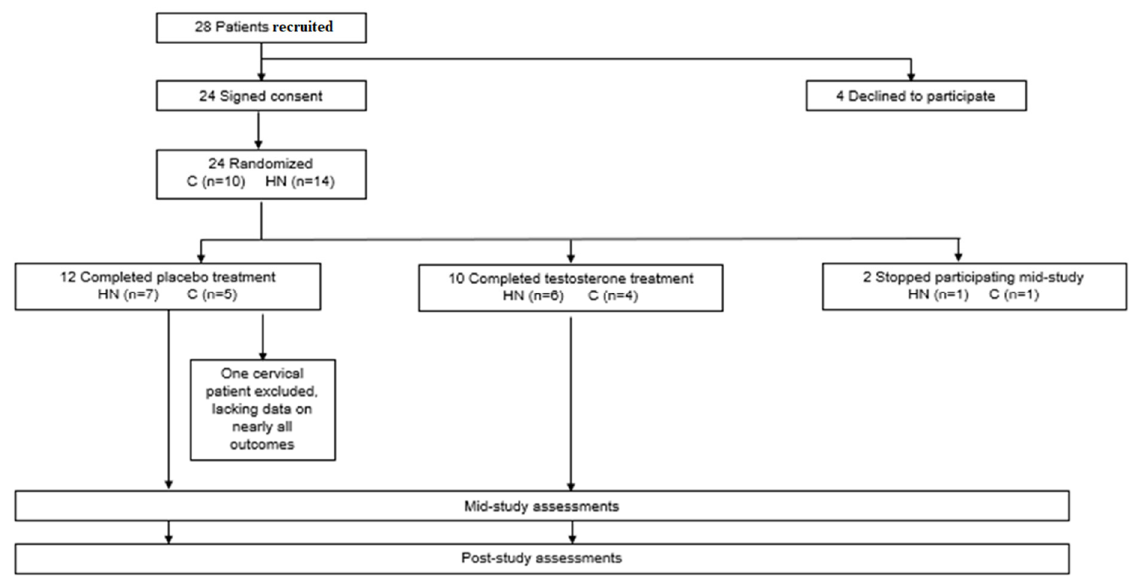
Figure 1. History of study participants from enrollment through post-study assessments.